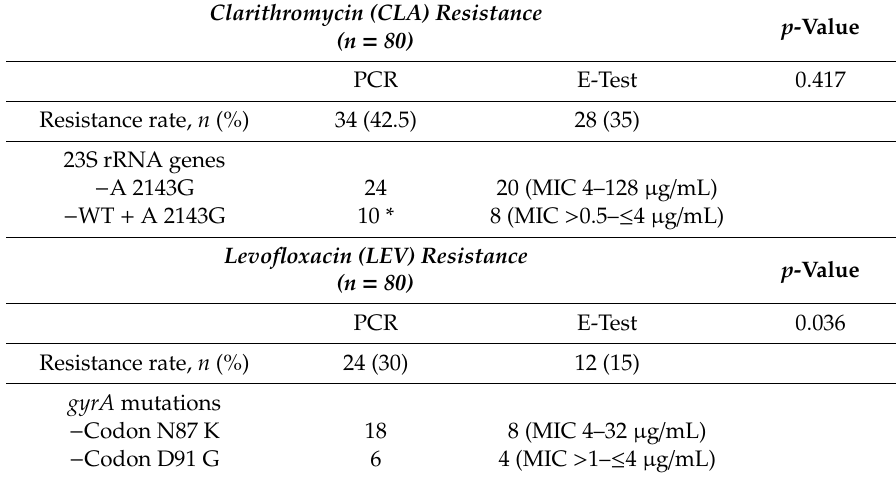
Table 2. Hp resistance to clarithromycin and levofloxacin: Comparison between real-time PCR and E-test